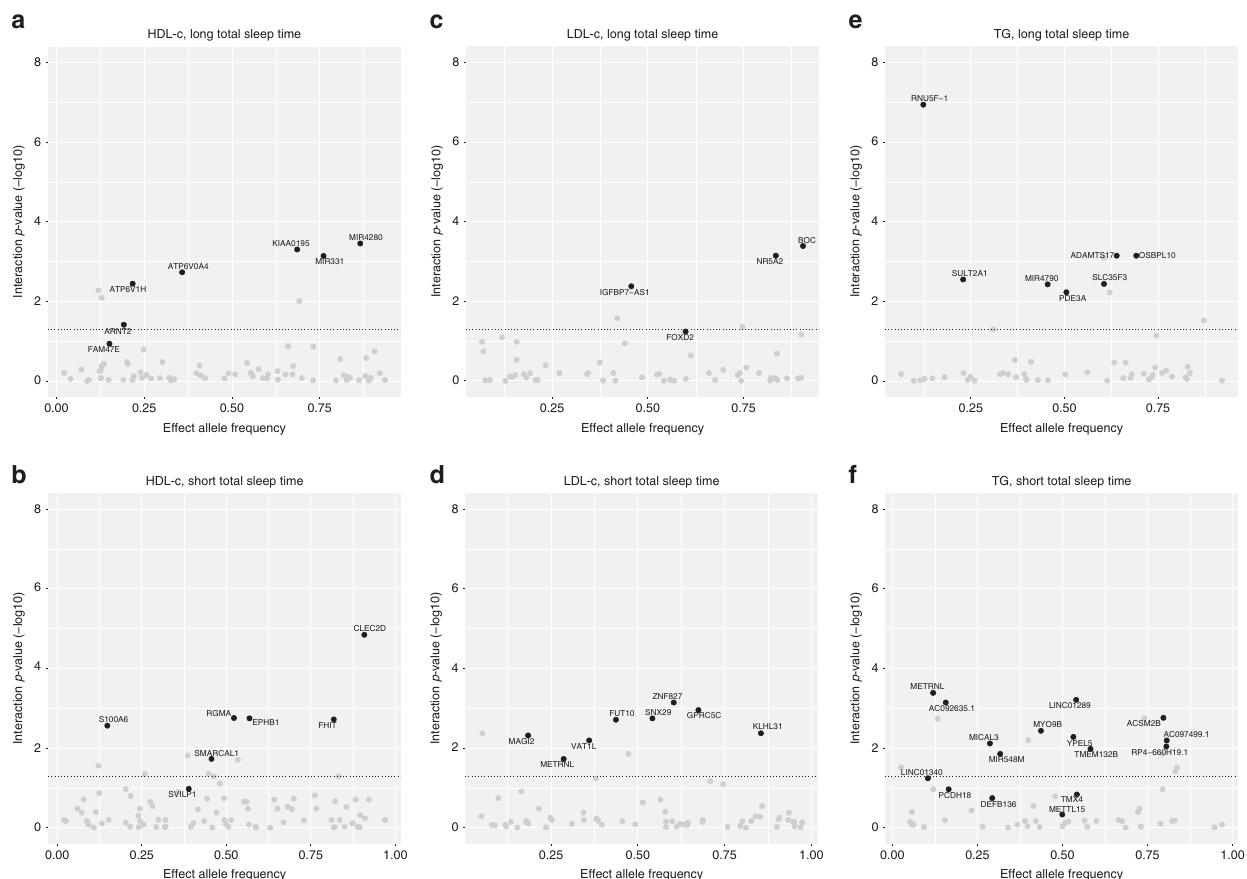
Fig. 3 Sleep-interactions in known and previously unreported regions. Plot displaying the – log( P -value) of the 1df interaction between the SNP and either LTST or STST on the lipid trait after correction for multiple testing using false discovery rate against the allele frequency of the effect allele. Dotted horizontal line resembles the cut-off for the 1df interaction P -value FDR < 0.05 after correction for multiple testing using false discovery rate. In black are the novel loci for lipid traits; in grey are the identi fi ed lead SNPs mapped within a 1 -Mb physical distance from a known lipid locus. Visualisation of the plots was performed using the R package ggplot2 105 . a HDL-c, long total sleep time; b HDL-c, short total sleep time; c LDL-c, long total sleep time; d LDL-c, short total sleep time; e triglycerides, long total sleep time; f triglycerides, short total sleep time